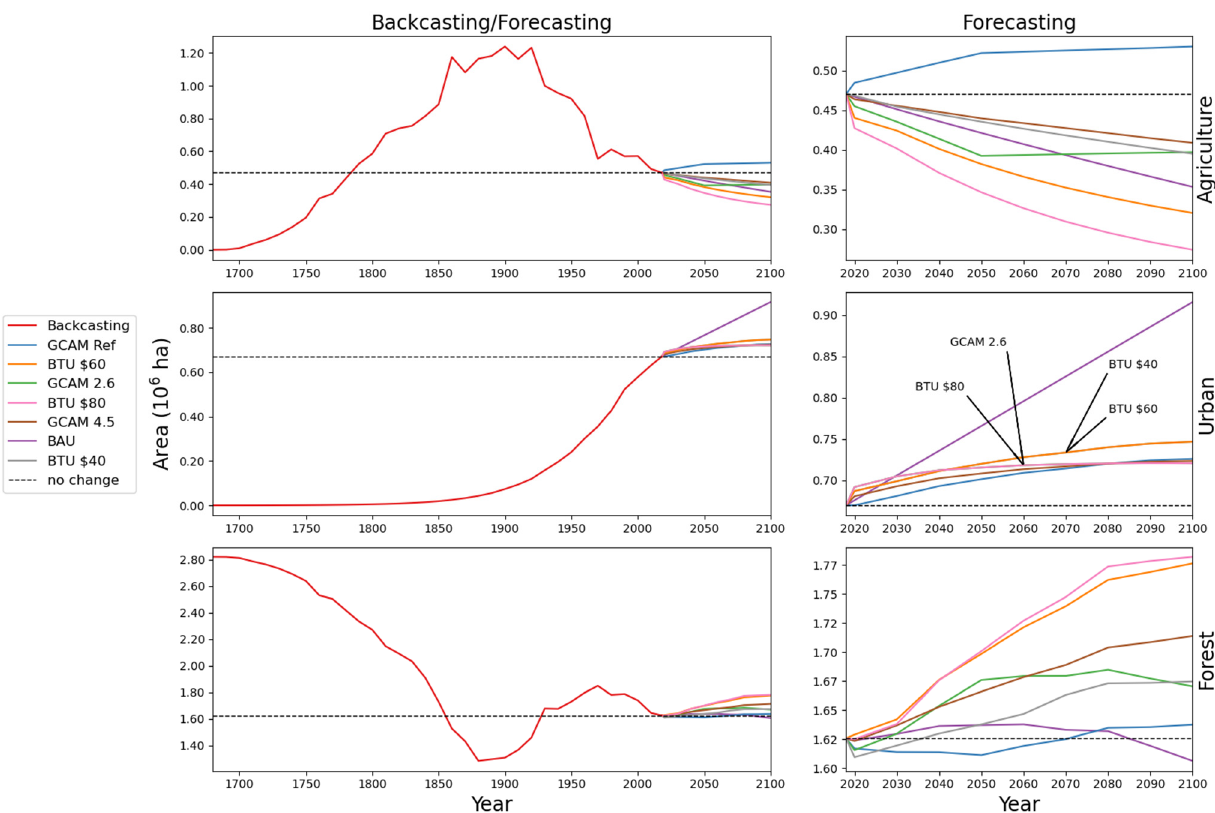
Figure 4. Modeled quantities for the aggregated land cover categories Agriculture (Hay/Alfalfa, Corn, Soybeans, Wheat, Fallow/Idle, Fruits/Vegetables, Perennial Grass, and Other Crops, top), Urban (Developed Low Intensity and Developed High Intensity, middle), and Forest (Deciduous, Evergreen, and Mixed, bottom). Backcasting/forecasting (left) panels cover the entire time series—1680 to 2100. Forecasting (right) panels reduce time series to projections—2018 to 2100. The “no change” baselines represent initial (2018) quantities. Respectively, the aggregated categories Agriculture, Urban, and Forest represent 14%, 20%, and 49% of the total region in 2018.